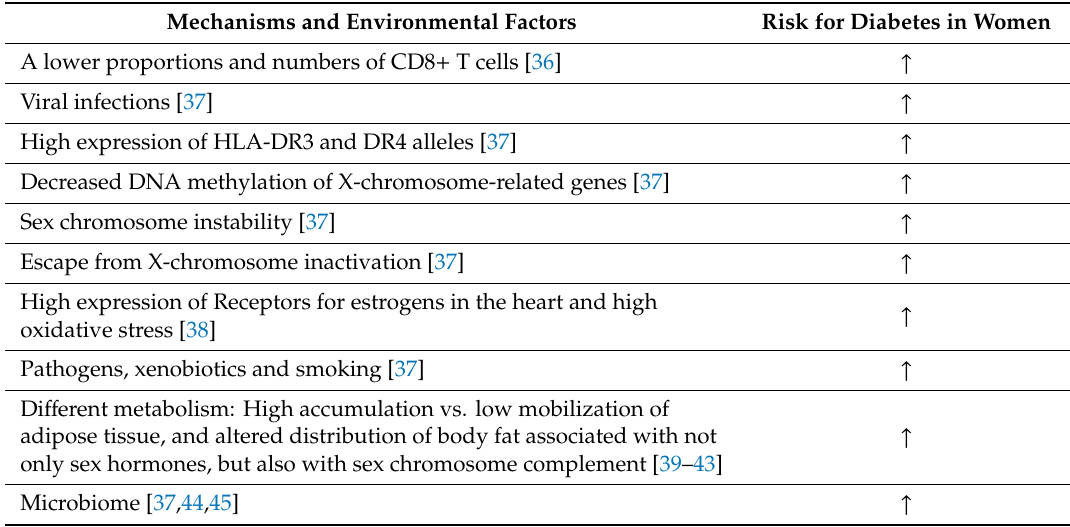
Table 1. Mechanisms and Risk Factors for Diabetes in